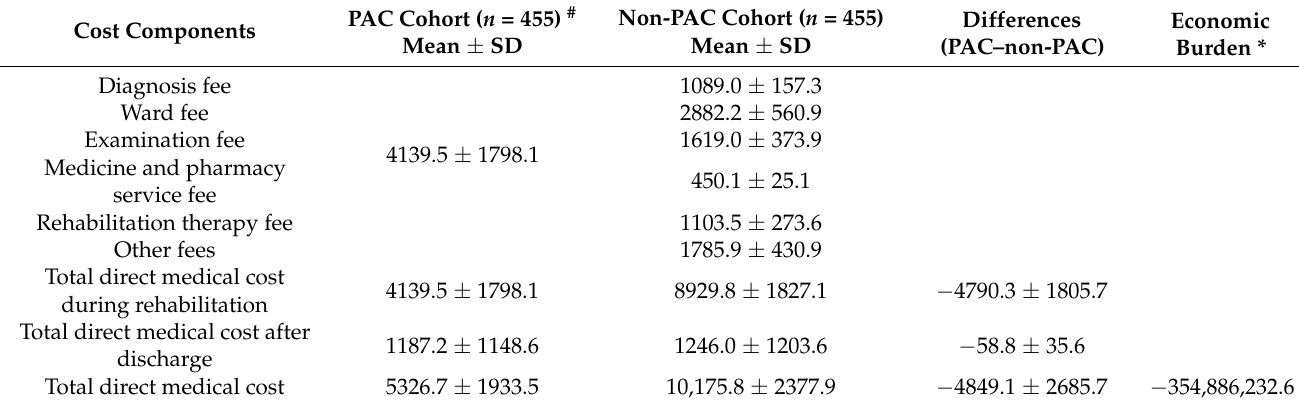
Table 2. Annual economic burdens of total direct medical cost per patient in PAC and non-PAC cohorts before and after one-year